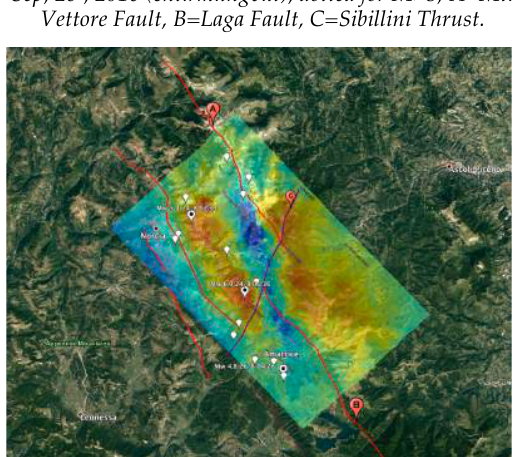
Figure 1: faults and earthquakes overlain on the E-W component of INSAR data [Marinkovic and Larsen, 2016], blue means eastwards; white pins for M>4 before Sep, 28 th , 2016 (cnt.rm.ingv.it), dotted for M>5; A=Mt. Vettore Fault, B=Laga Fault, C=Sibillini Thrust.